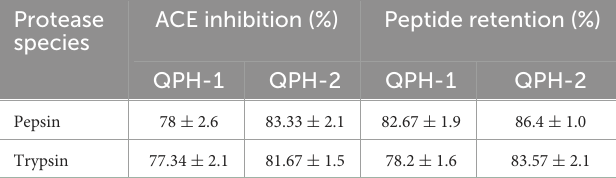
TABLE 5 Effect of pepsin and trypsin on peptide yield and ACE